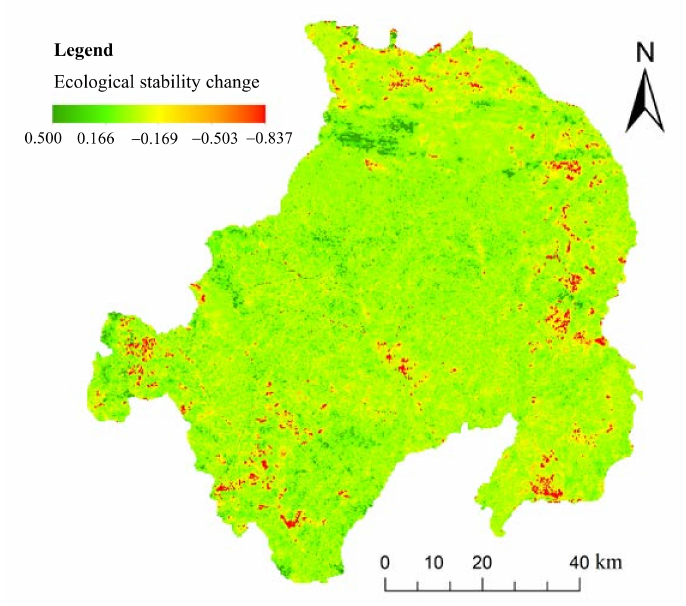
Figure 10. Changes in ecological stability of Jungar Banner between 2002 and 2017 (In the figure, the legend of the ribbon, “+” indicated that the ES was increased, and the ecological environment was better, “ − ” indicated that the ES was decreased and the ecological environment was